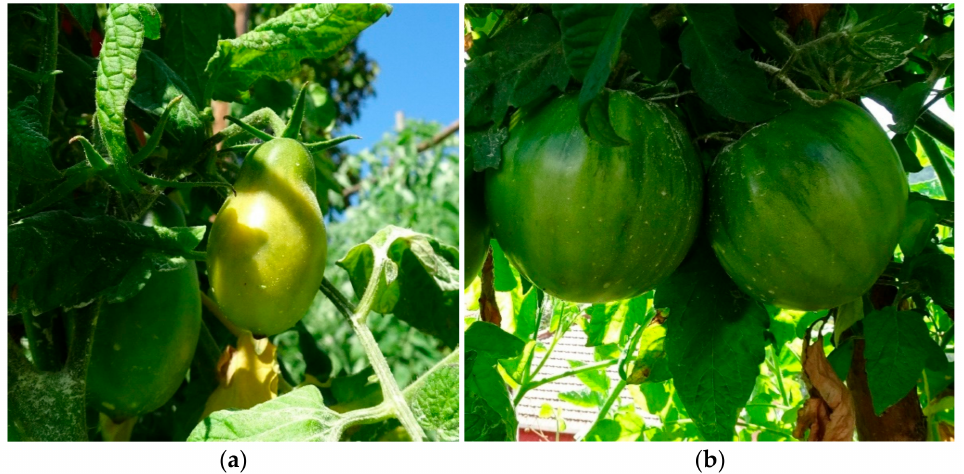
Figure 3. ( a ) Immature fruit of tomato landrace ”Kydonati”, ( b ) immature fruit tomato of landrace “Strogili” found in Kastri